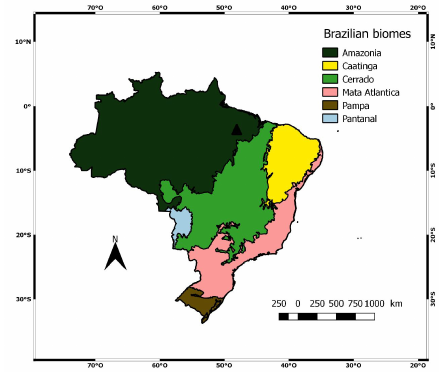
Figure 1. Spatial distribution of Brazilian biomes. ​